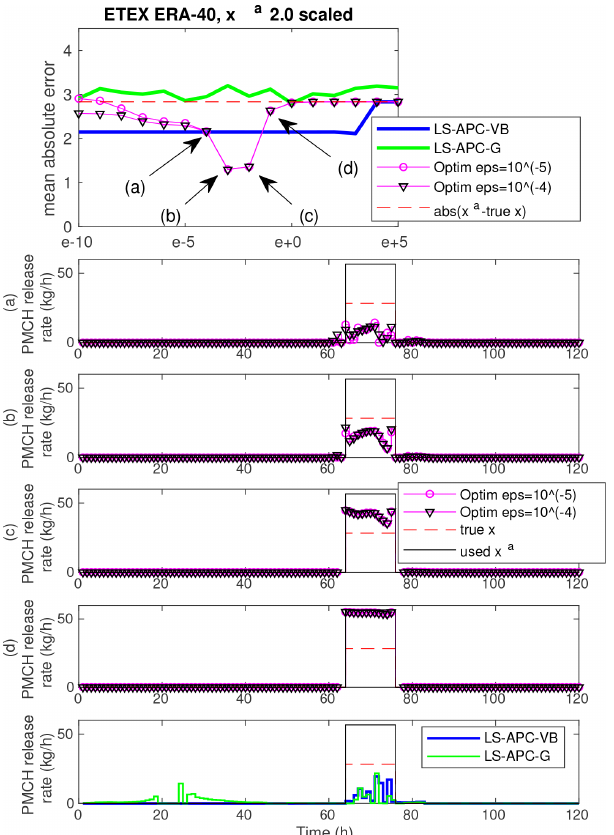
Figure 3. The uppermost panel shows mean absolute errors between estimated and true source terms for the ETEX ERA-40 dataset with x a 2.0 scaled for all methods. Certain settings of the tuning parame- ter are highlighted and labeled with (a) , (b) , (c) , and (d) . Estimated source terms for these tuning parameter choices are given in the panels below. The lowermost panel displays the estimated source terms from the LS-APC-VB and LS-APC-G algorithms for com- parison.